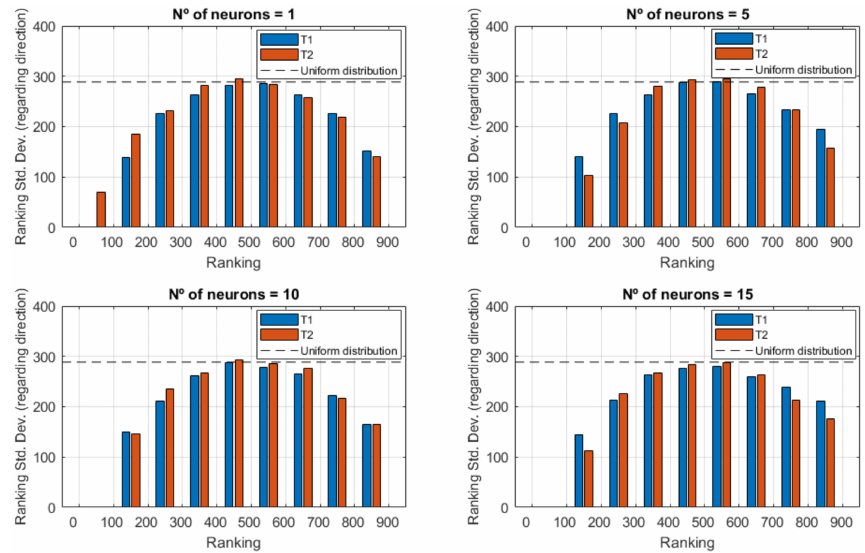
Figure 11. Network ranking dispersion with respect to the spring direction.